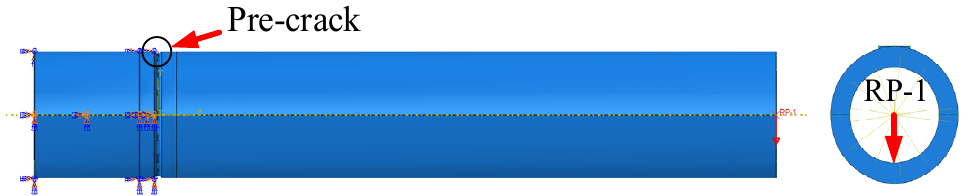
Figure 12. Application of boundary condition.